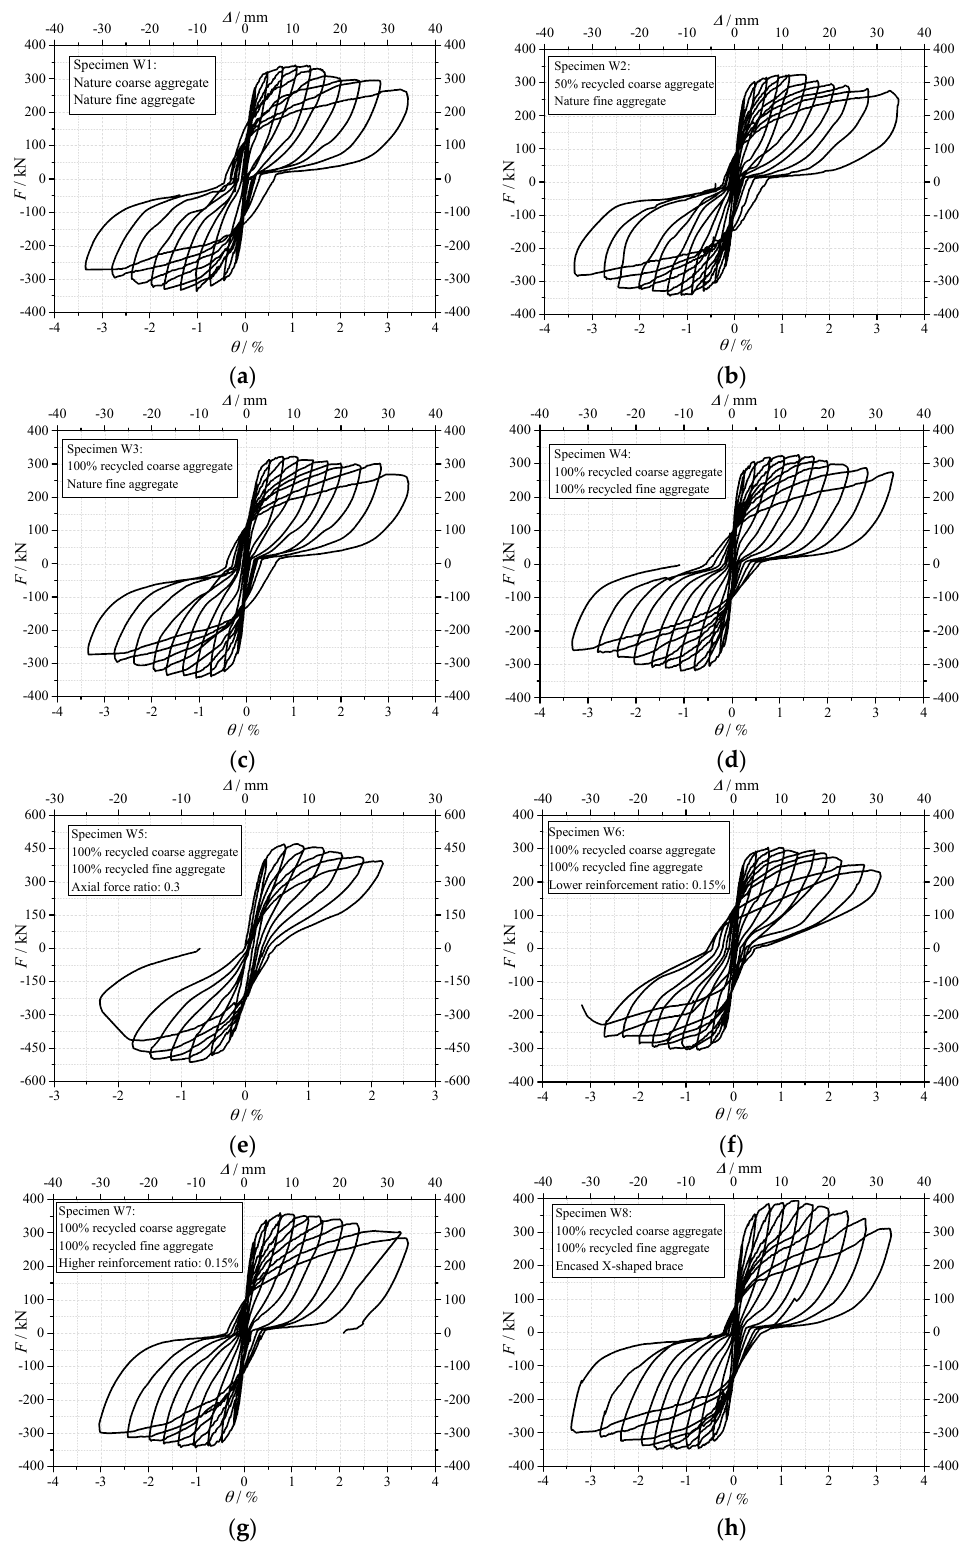
Figure 8. Hysteretic curves of the horizontal load F -drift ratio θ . ( a ) Specimen W1; ( b ) Specimen W2; ( c ) Specimen W3; ( d ) Specimen W4; ( e ) Specimen W5; ( f ) Specimen W6; ( g ) Specimen W7; ( h ) Specimen W8.